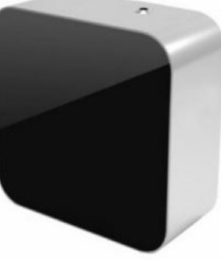
Figure 2. Odor diffusion system (Scentcube, Iscent, Zeewolde, The